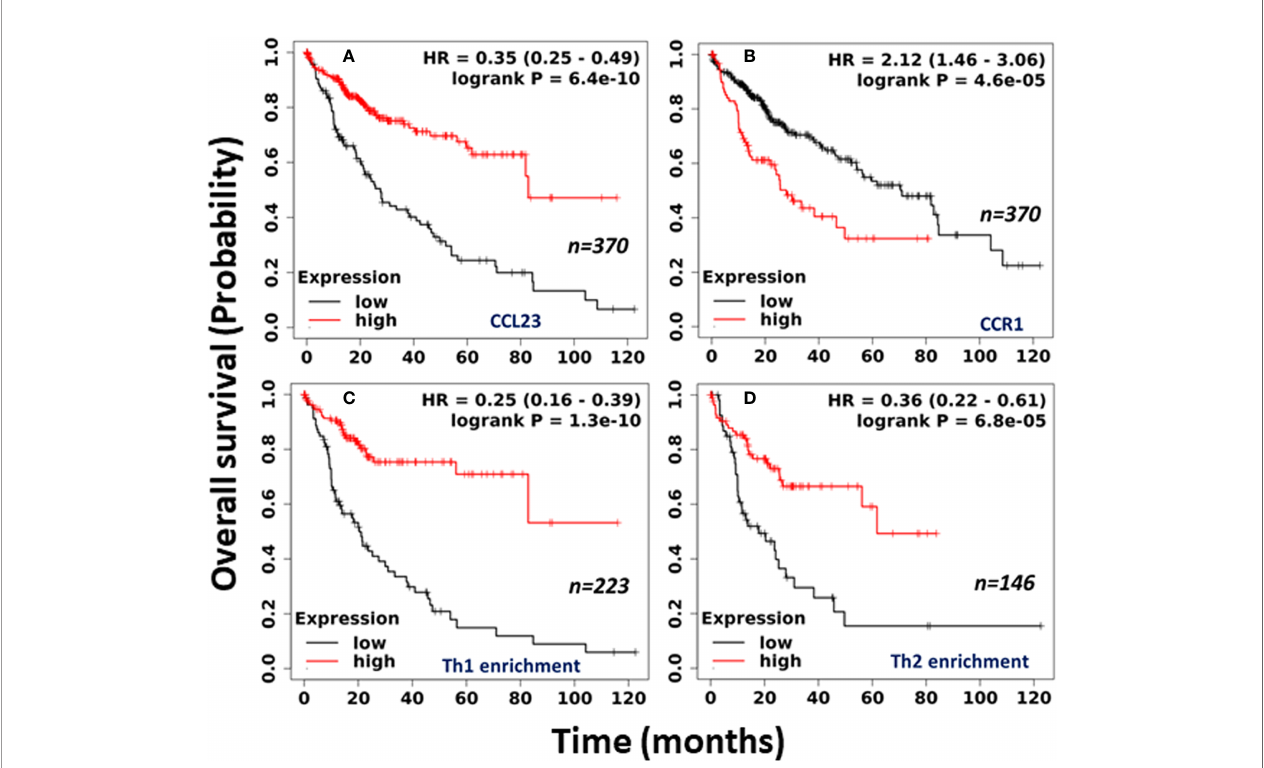
FIGURE 2 | Clinical association of (A) CCL23; (B) CCR1; (C) Th1 cell enrichment; and (D) Th2 cell enrichment in human HCC tissues with overall survival. (Data source: Kaplan-Meier Plotter, Pan-cancer